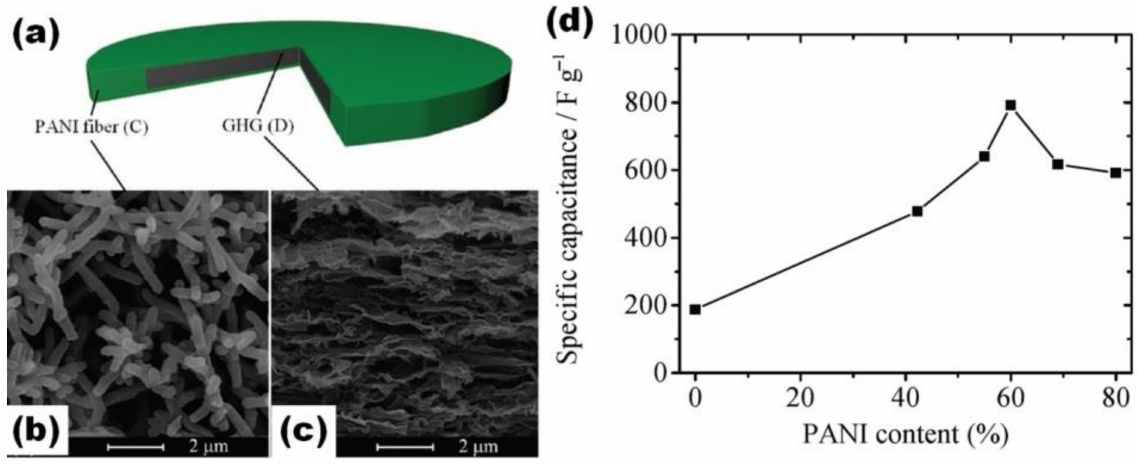
Figure 17. Schematic image illustrating pressed GH/PANI electrode ( a ). Microstructures of the PANI cap layer ( b ) and GH matrix ( c ). Specific capacitance as a function of PANI content ( d ) (Reprinted from [49] with permission of